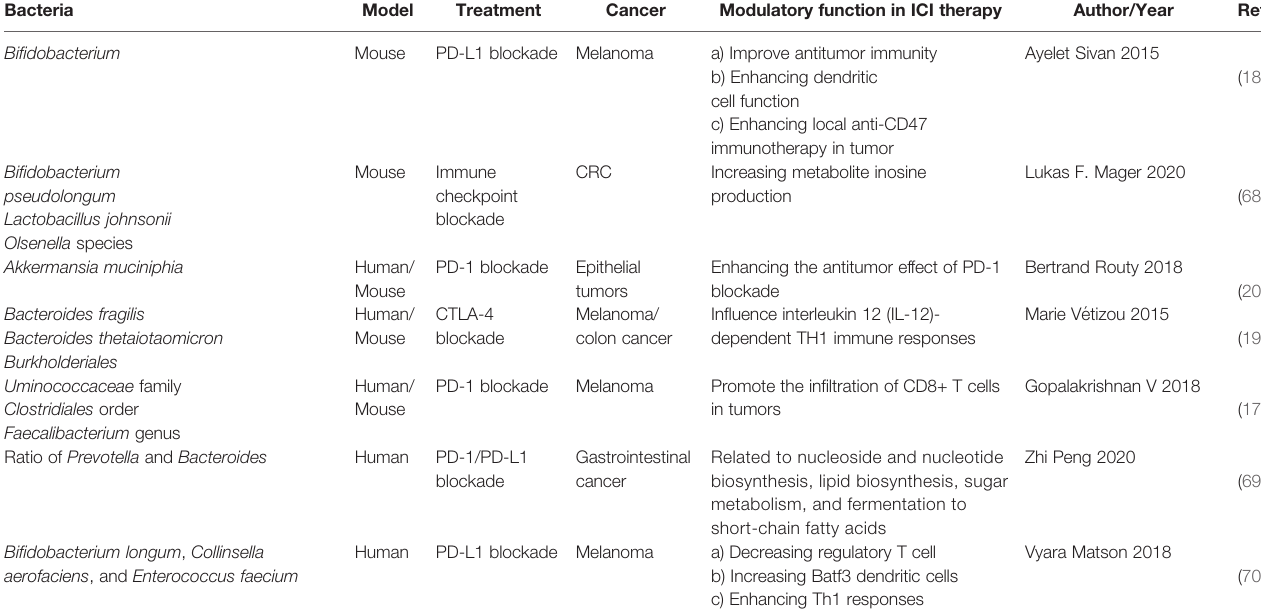
TABLE 1 | Modulatory function of gut microbiome in ICIs therapy.